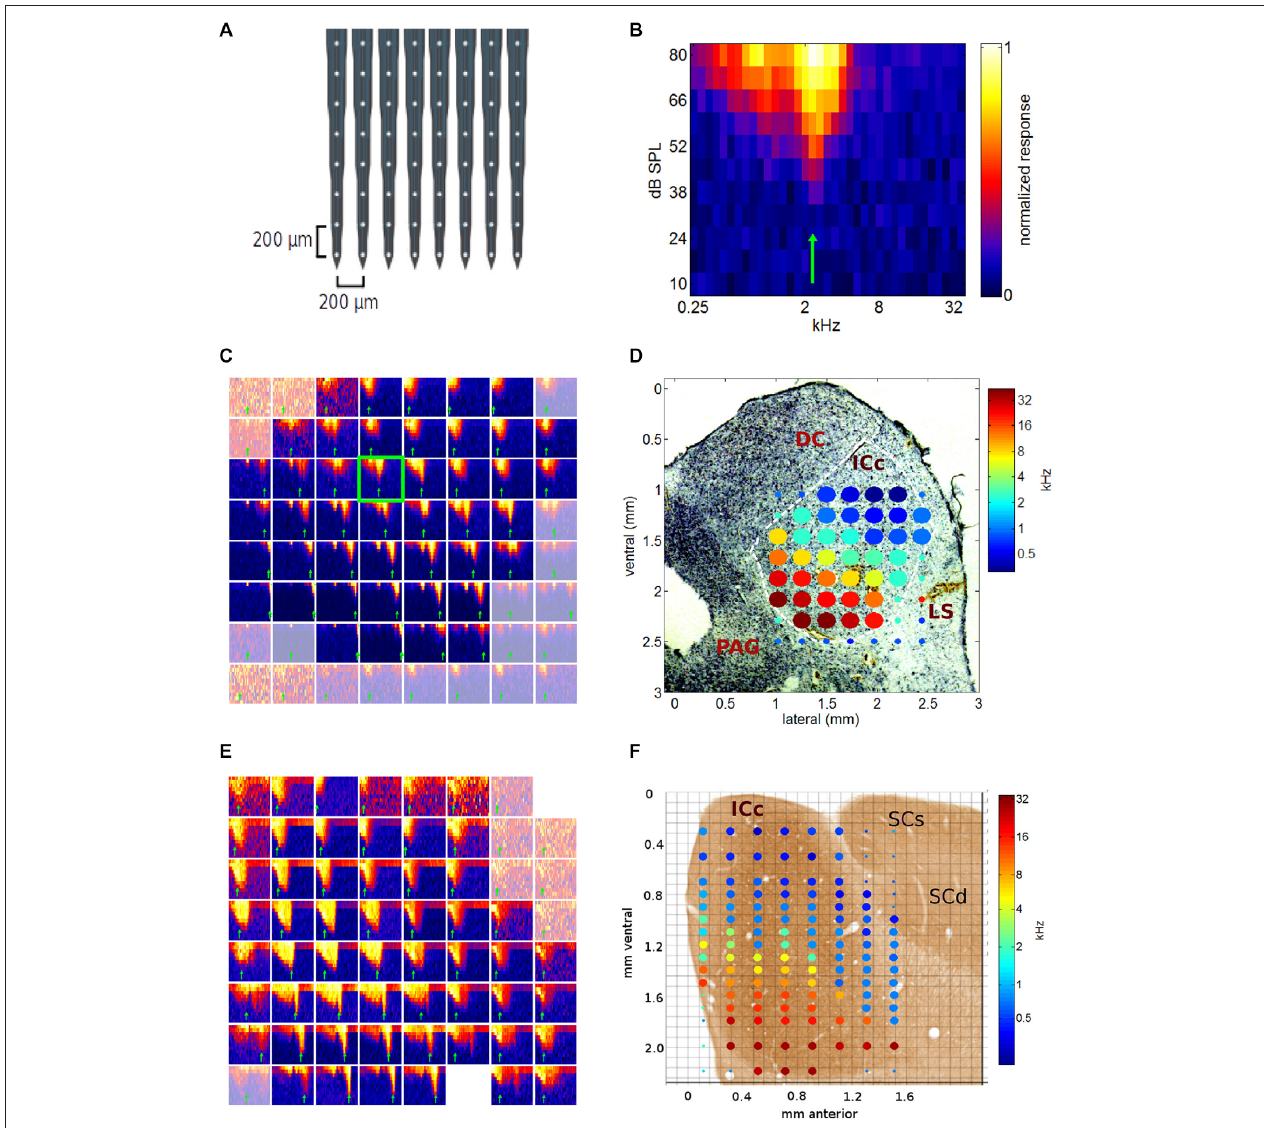
circles indicates the BF for each recording site according to the color scale on the right. Large filled circles show BFs of recording sites located within ICc, small circles indicate recording sites outside ICc. The axes show coordinates in mm from the mid-line and the dorsal edge of the midbrain respectively. DC, dorsal cortex of the IC; LS, lateral shell of the IC; PAG, periaqueducal gray. (E) FRAs as in (C) , recorded during a multielectrode penetration oriented along the sagittal plane. Two of the channels on this multielectrode array were faulty, hence two FRAs are missing, one at the top right, the other in the bottom row. (F) Composite showing the BFs obtained from the data shown in (E) , as well as the data from a second recording location, 0.5 mm deeper, superimposed to scale onto a photo-micrograph of a sagital section through the gerbil IC taken from page 21 of Cant and Benson (2005; by kind permission of the publisher). SCs, superior colliculus, superficial layers; SCd, superior colliculus, deep layers.